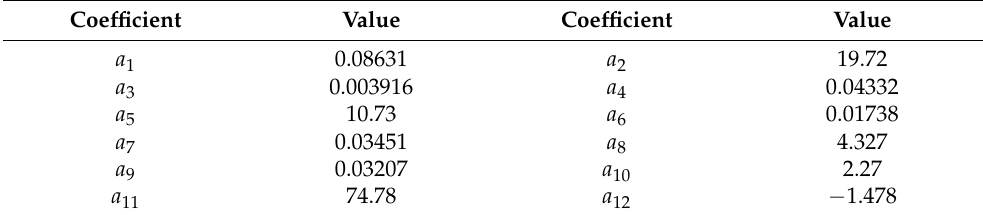
Table 4. The value of coefficients in R 1 - SOC - T fitting